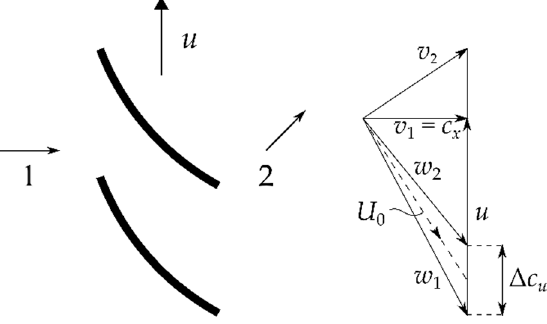
Figure 9. Velocity triangles.